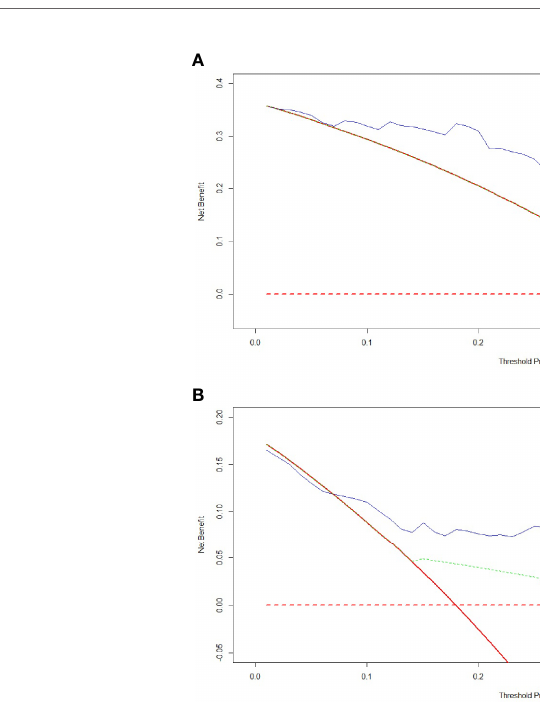
FIGURE 4 | Decision curve analysis (DCA) of the nomogram and breast immune prognostic index (BIPI) for predicting the disease-free survival (DFS) and overall survival (OS). The X-axis represents the threshold probability, and the Y-axis shows the net bene fi t. The lines between the X-axis and the Y-axis display the bene fi t of different predictive variables. The red dotted line suggests that no patient has poor prognosis, while the red line indicates that all patients have poor prognosis. The blue line represents BIPI with other independent prognostic factors by the COX proportional hazard regression model, and the green line represents only BIPI. (A) DCA of the nomogram and BIPI for predicting the 5-year DFS. (B) DCA of the nomogram and BIPI for predicting the 5-year